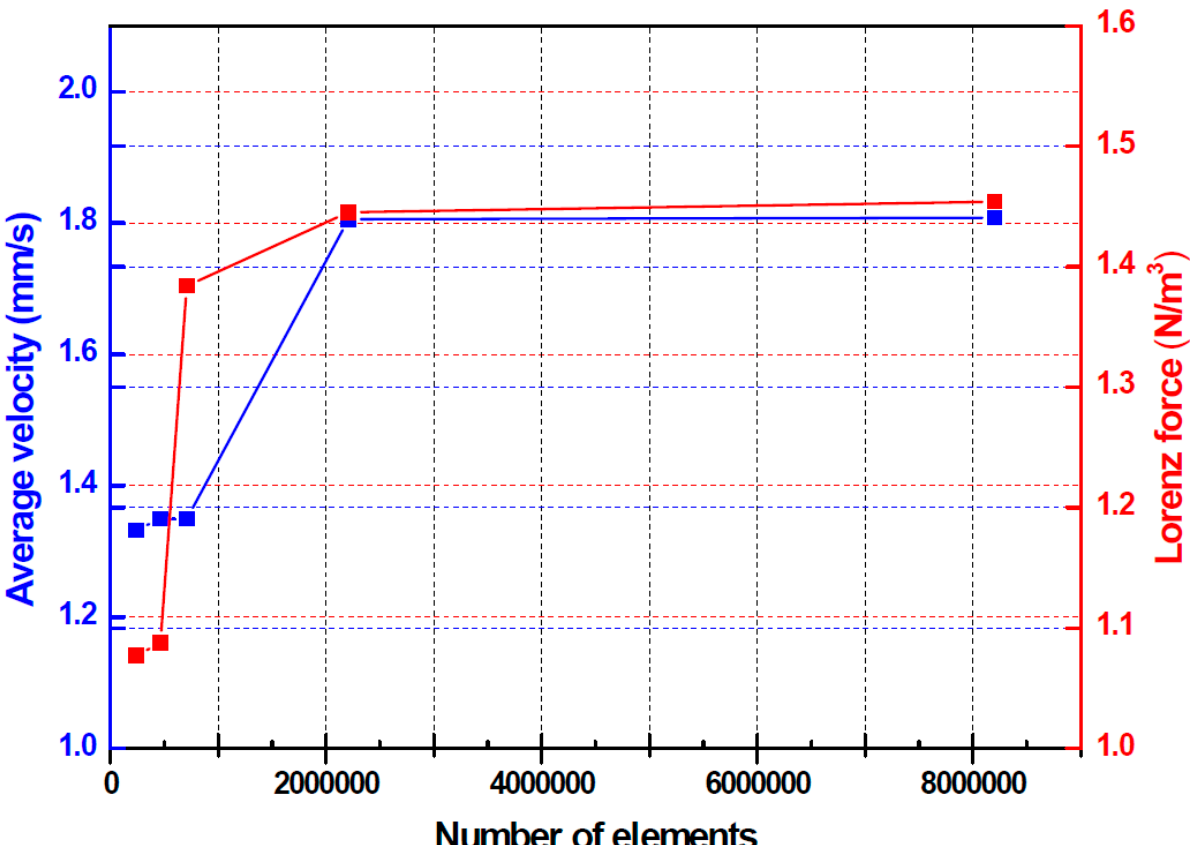
Figure 3. Simulated results for various mesh element numbers.